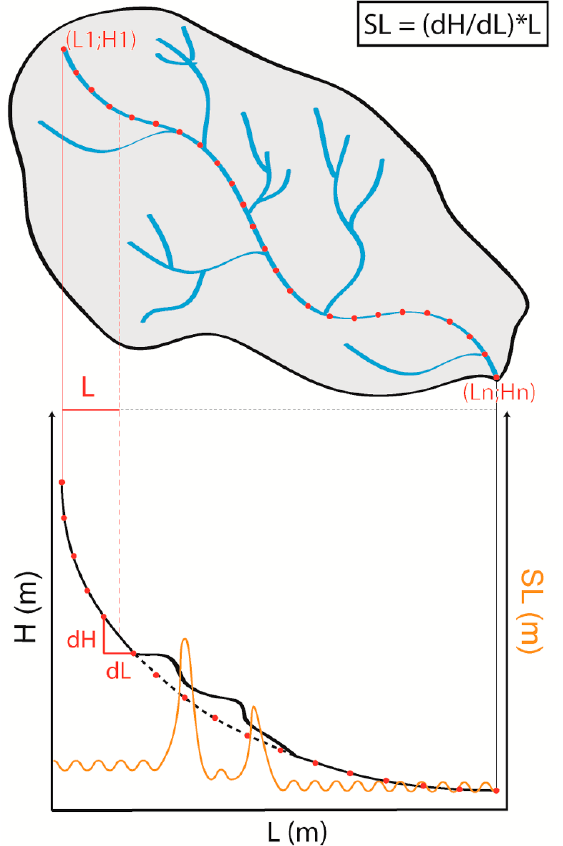
Figure1. Figure 1. Scheme introducing to the along ‐ stream calculation of SL values following the Hack’s equation.